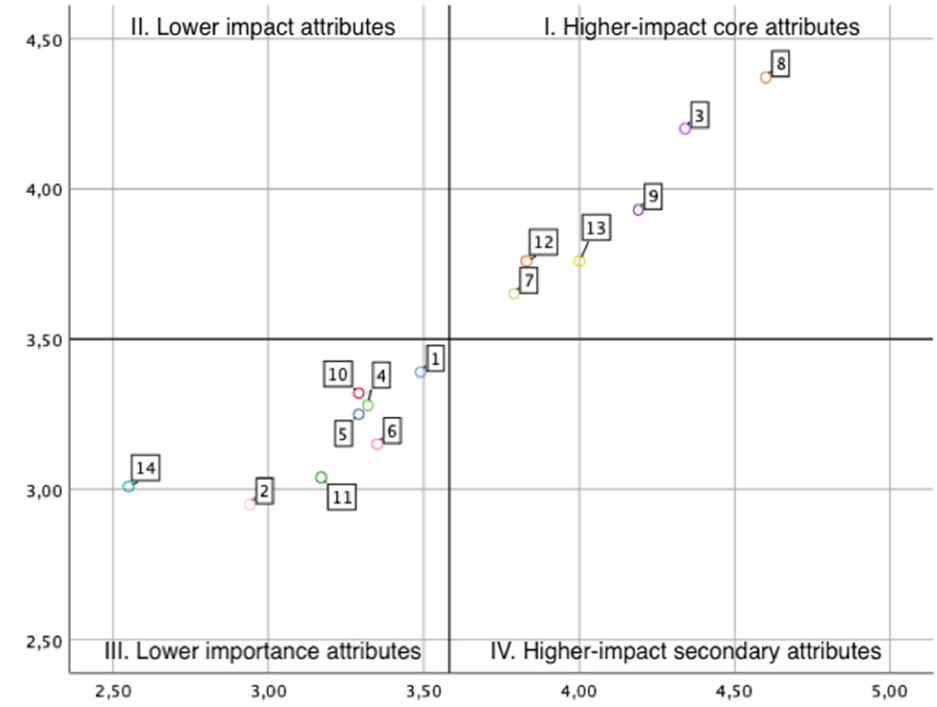
Figure 4. Relevance-determination matrix.